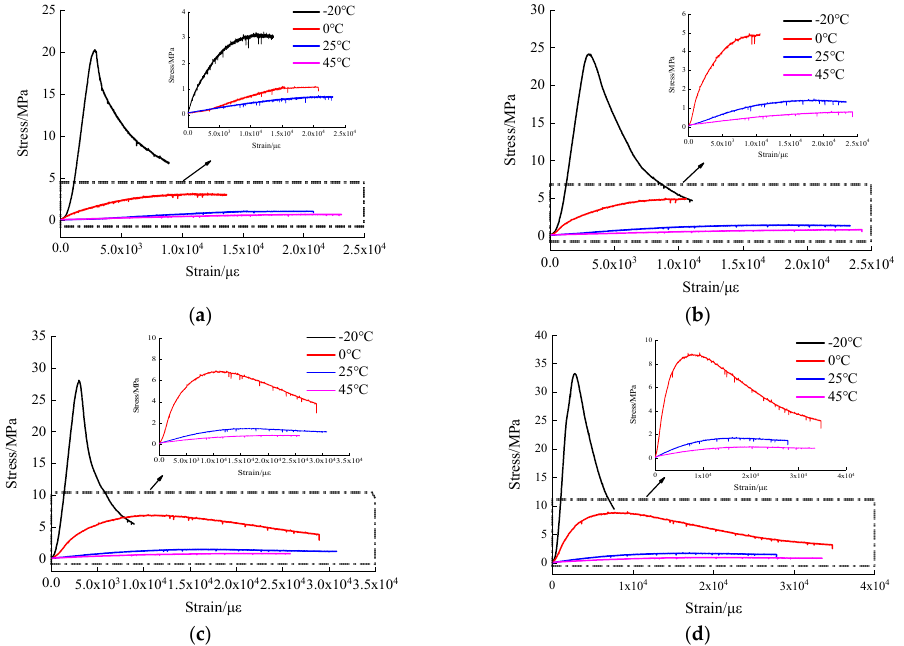
Figure 5. Stress-strain curves of hydraulic asphalt concrete under different strain rates. ( a ) strain rate 10 − 5 /s; ( b ) strain rate 10 − 4 /s; ( c ) strain rate 10 − 3 /s; ( d ) strain rate 10 − 2 /s.